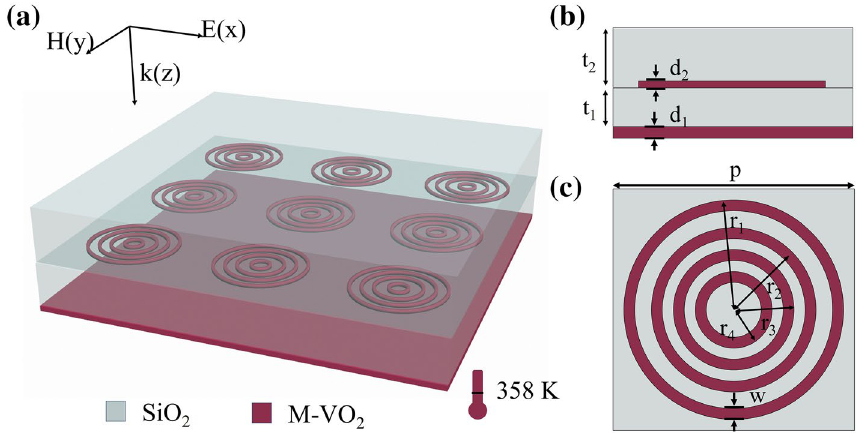
Figure 1. ( a ) Schematic diagram of the ultra-broadband adjustable metamaterial absorbing structure based on VO 2 . Four-ring nested VO 2 periodic array structure with thickness of 0.5 μm is embedded between two layers of SiO 2 . Bottom layer is 1 μm-thick VO 2 film. At 358 K, VO 2 transforms into metal state, and the structure exhibits THz broadband absorption characteristics. ( b ) Side-view and ( c ) top-view of unit cell. Geometric parameters are p = 90 μm, r 1 = 42 μm, r 2 = 34 μm, r 3 = 25 μm, r 4 = 19 μm, t 1 = 22 μm, t 2 = 39 μm, d 1 = 1 μm, d 2 = 0.5 μm, and w = 2 μm,